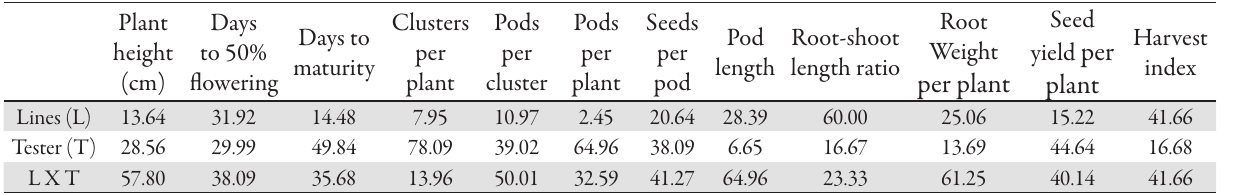
Tab. 7. Per cent contributions of lines, testers and their interactions to total variance of various traits in the black gram crosses